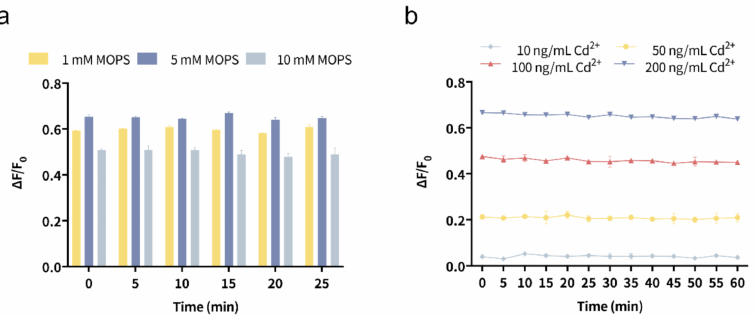
Figure 4. Stability of fluorescence quenching efficiency ( ∆ F / F 0 ) in time scale under ( a ) different concentrations of MOPS (1, 5, and 10 mM, pH 9.0) mixed with 20 nM FAM-aptamer and 200 ng mL − 1 Cd 2+ , and under ( b ) 5mM MOPS (pH 9.0) mixed with 20 nM FAM-aptamer and various concentrations of Cd 2+ (10, 50, 100, and 200 ng mL − 1 ) at room temperature. (n ≥ 3).